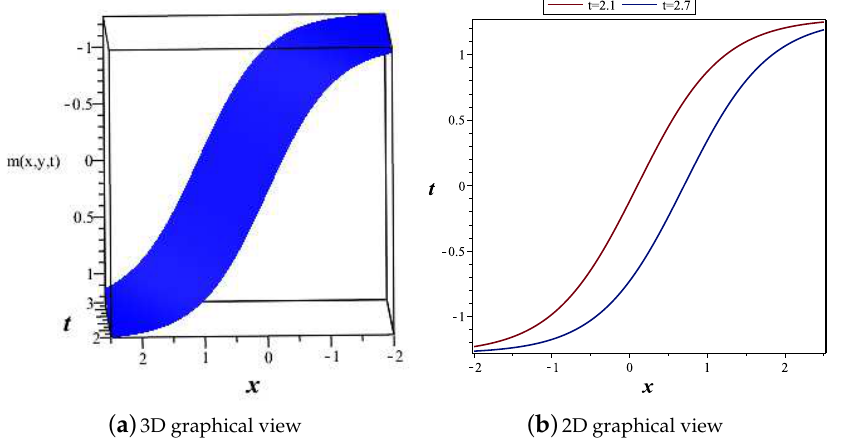
Figure 7. Graphical behavior of Equation (54) within interval − 2 ≤ x ≤ 2.5 and 2 ≤ t ≤ 3 (( a ) 3D plot, ( b ) 2D plot for t = 2.1, 2.7).